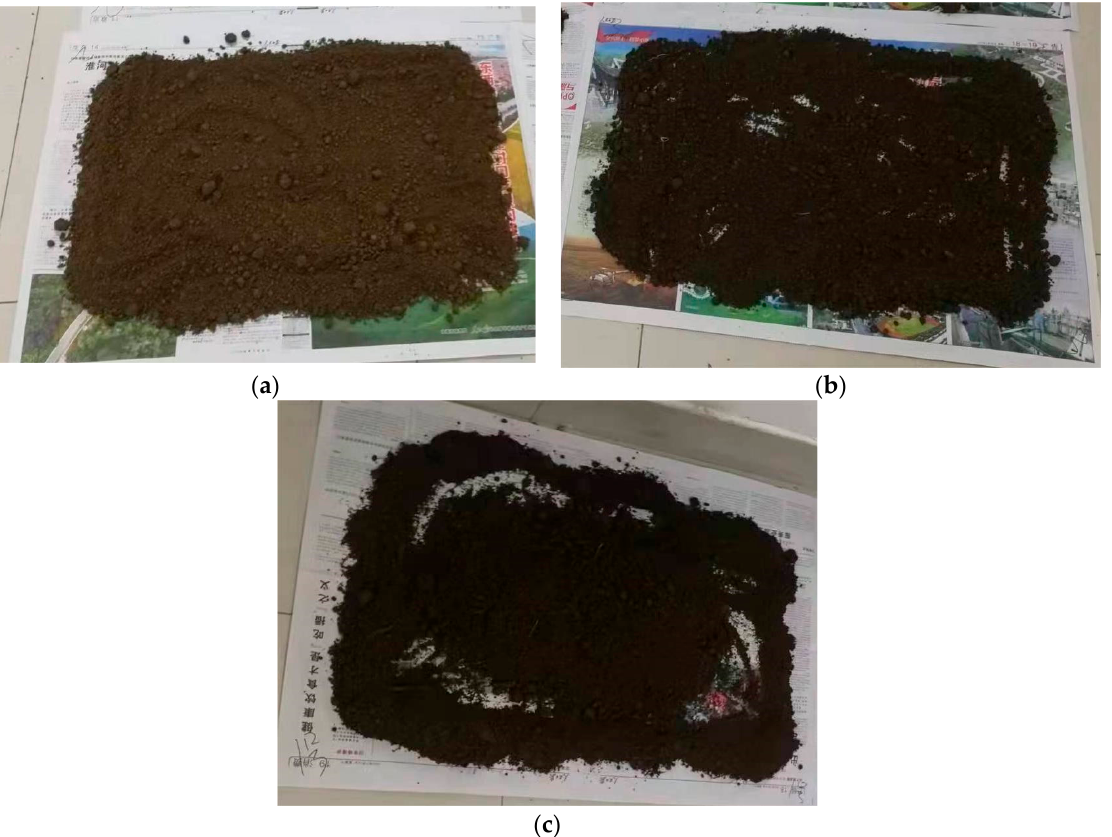
Figure 3. Pictures of soil samples. ( a ) Picture of soil sample CH. ( b ) Picture of soil sample CD. ( c